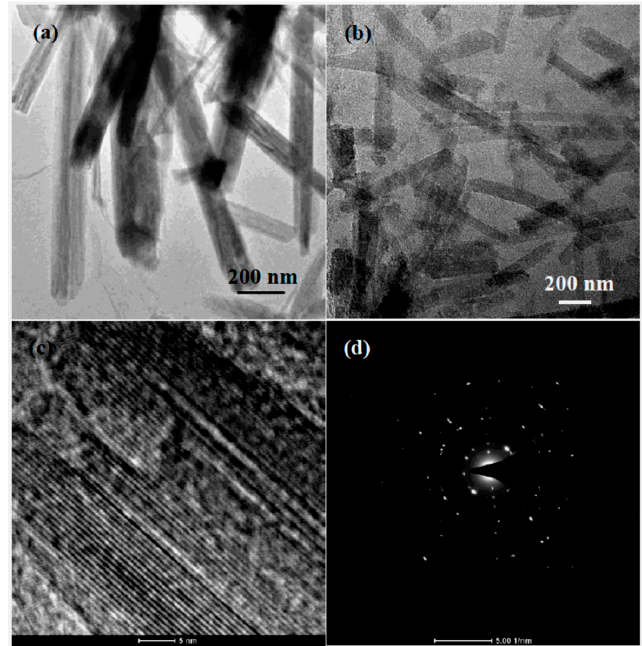
Figure 4. TEM images of LiMn 2 O 4 ( a ), gradually enlarged TEM images ( b , c ), and SAED pattern ( d ) of the LiMn 2 O 4 -graphene film.